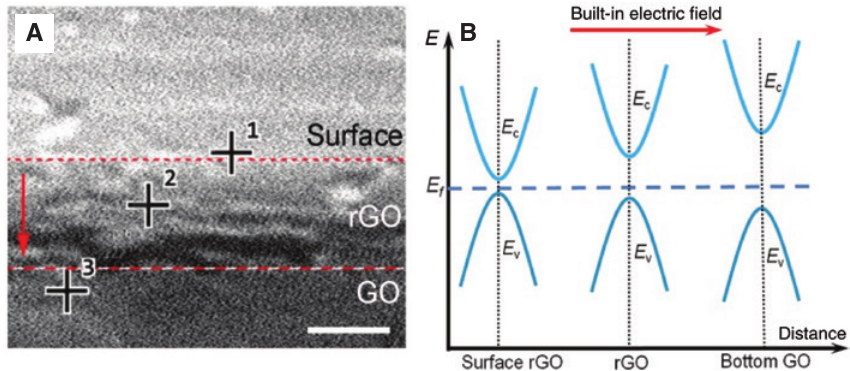
Figure 5: Gradient C/O ratios in the laser-scribed rGO films. (A) Inclined cross-sectional SEM image of a thick rGO film. The scale bar is 1 μ m, The ratios at points 1–3 can be determined by EDX. (B) Scheme of the energy alignment across the rGO film, in which E Fermi level. Red arrows denote the built-in electric field in the